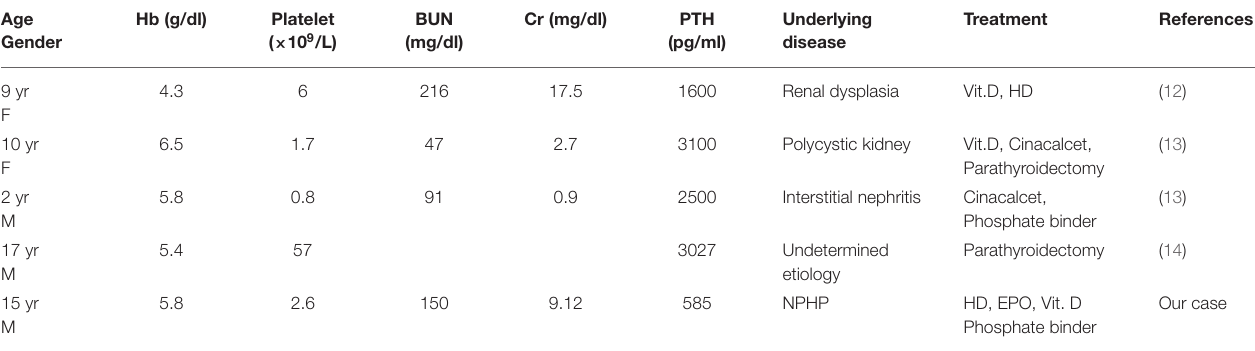
TABLE 1 | Myelofibrosis in pediatric cases (aged < 20 years old) with end-stage renal disease in the literature. Age Hb (g/dl) Platelet BUN Cr (mg/dl) PTH Underlying Gender ( × 10 9 /L) (mg/dl) (pg/ml) disease